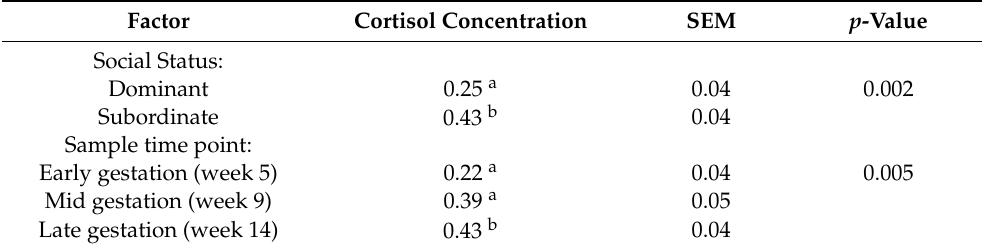
Table 8. E ff ect of social status and sample time point on salivary cortisol levels (LS Means, µ g / dL) in focal